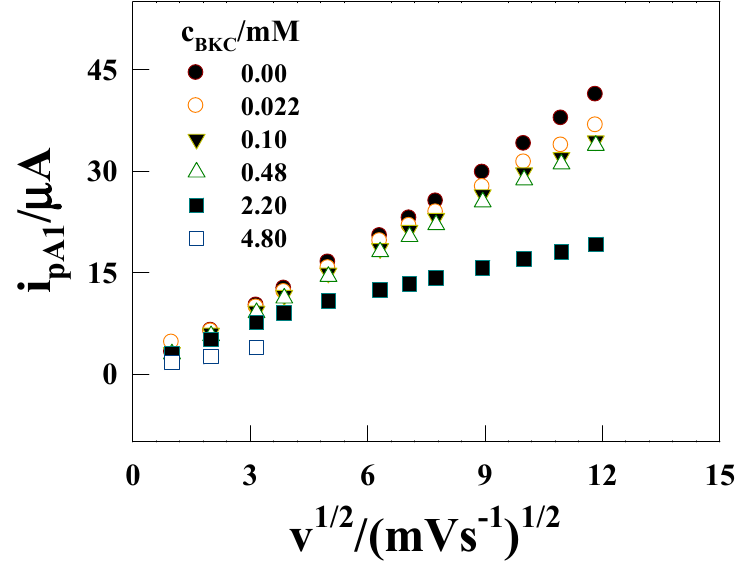
Figure 4. i pA1 versus v 1/2 plots for the oxidation of 1 mM [Co(II)(bpy) 3 ] 2+ on a GCE in 0.1 M Na 2 SO 4 solution in presence of various concentrations of BKC (mM mentioned in the figure).